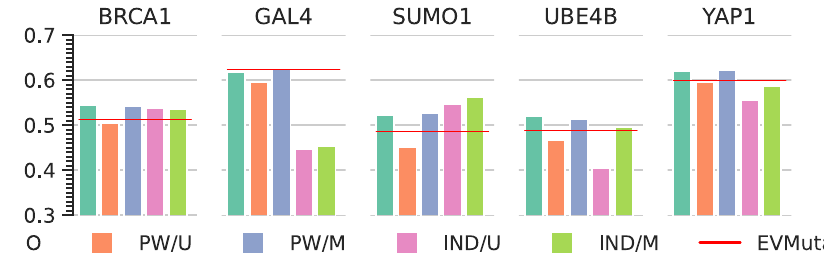
Fig 3. Spearman correlation with experimental data of original (O) and extracted models (PW/U, PW/M, IND/U, IND/M) for ArDCA. Shown is the Spearman rank correlation between the experimental data and the energies of the original model (O), the pairwise and independent models extracted using samples from a uniform distribution (PW/U and IND/U) and for the pairwise and independent models extracted using samples from the original model distribution (PW/M and